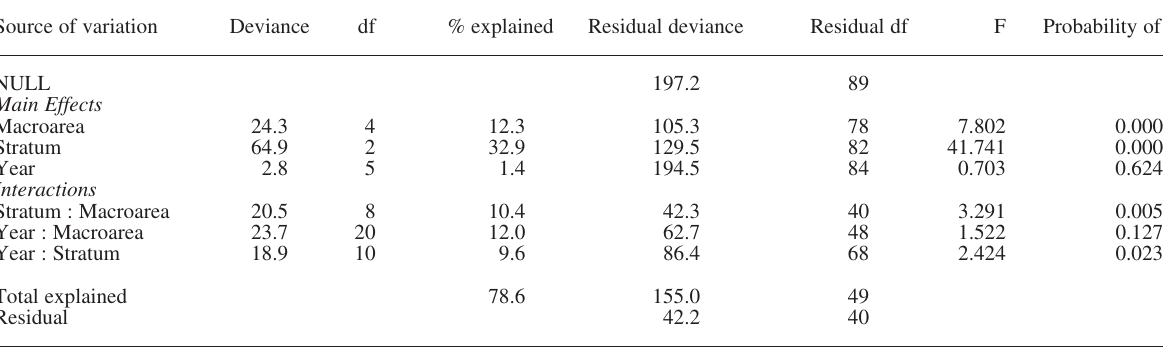
T ABLE 11. – Solea vulgaris : analysis of deviance table for generalised linear models fitted to MEDITS biomass indices (g/km 2 ) obtained in the years 1994-1999. Source of